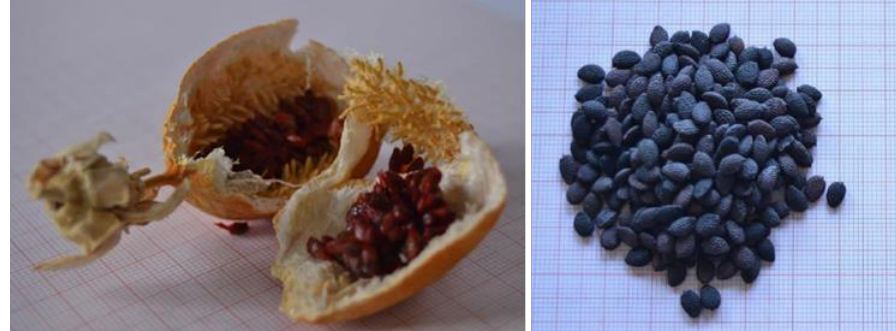
Figure 2. Dehydrated fruit of Passiflora incarnata , with seeds enclosed in the red and mucilaginous aril (on the left). Seeds used in experiments (on the right).